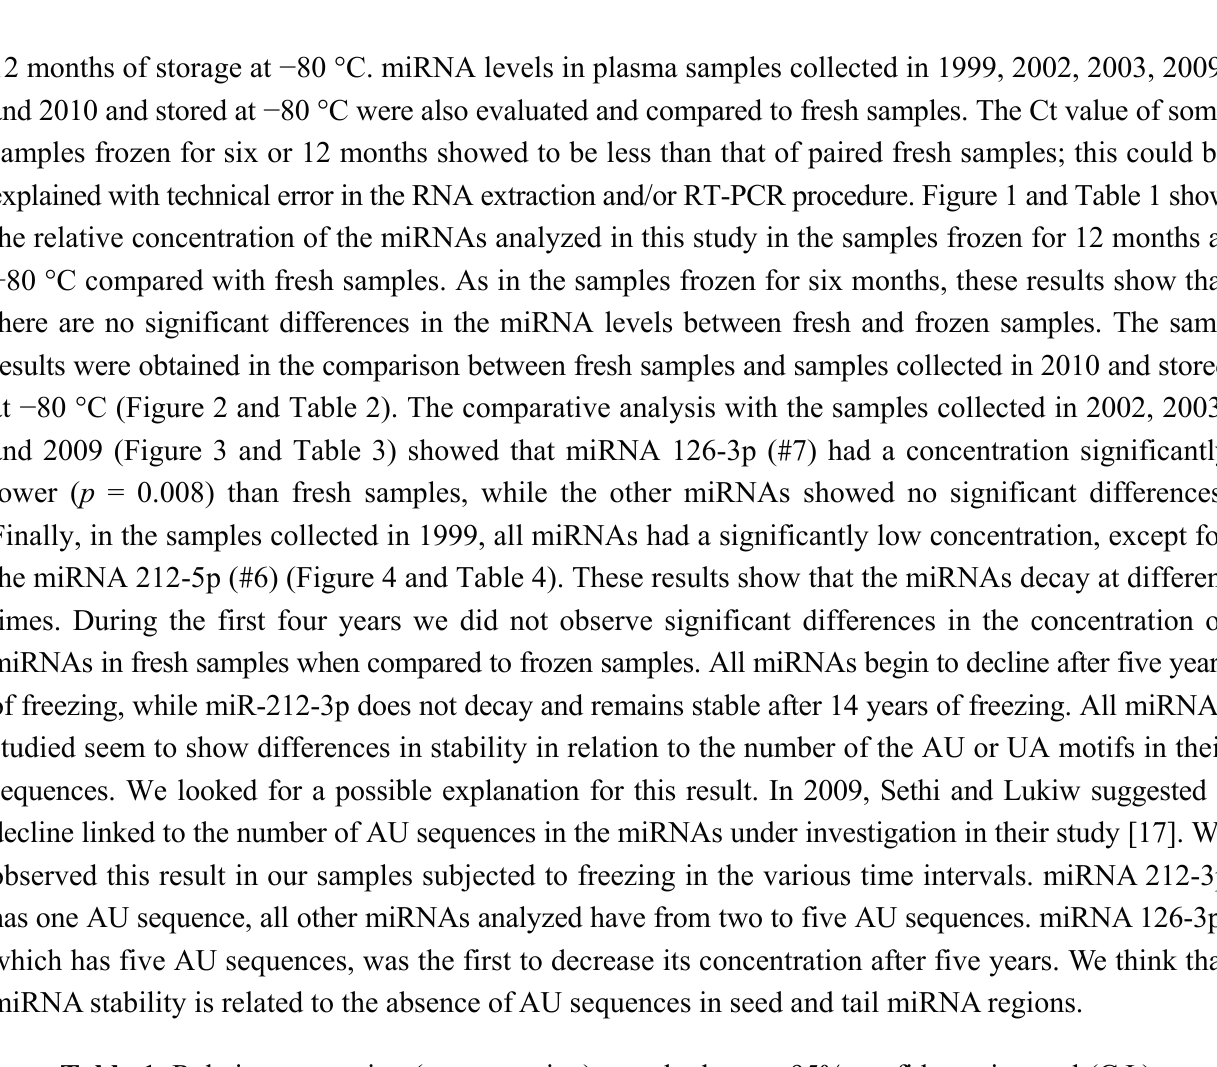
Table 1. Relative expression (concentration), standard error, 95% confidence interval (C.I.), and p -value of miRNAs analyzed in this study (samples frozen for 12 months compared with fresh samples). p -value ( ≥ 0.05) shows that there are no significant